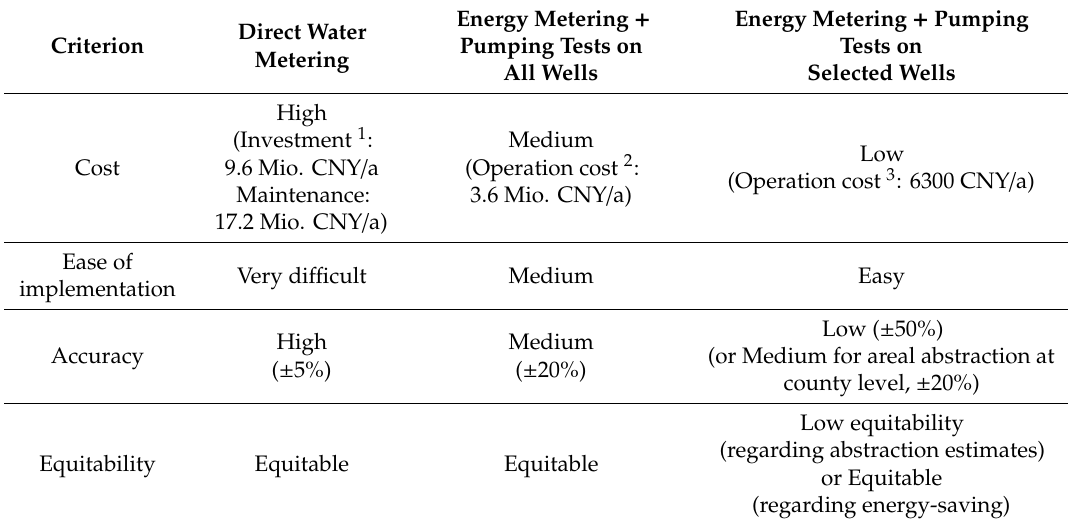
Table 3. Comparison of monitoring methods regarding cost, ease of implementation, accuracy and equitability for farmers. 1 CNY is approximately 0.15